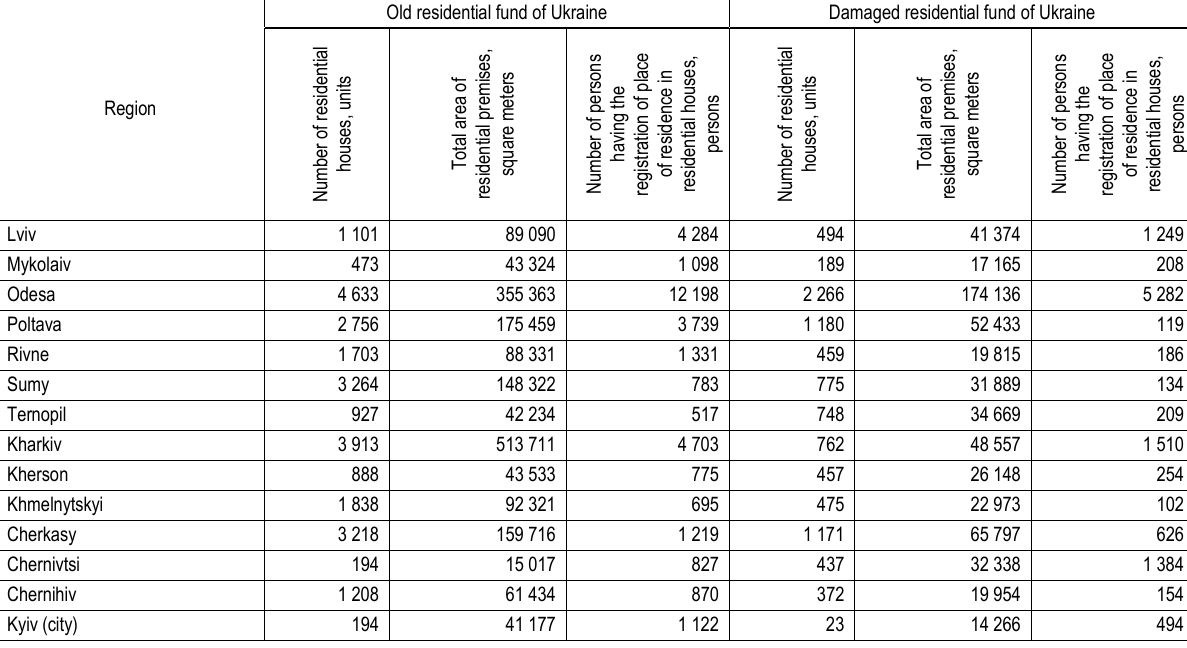
Table 3. (cont.) Indicators of the state of old and damaged residential premises in Ukraine and its regions in 2016 Old residential fund of Ukraine Damaged residential fund of